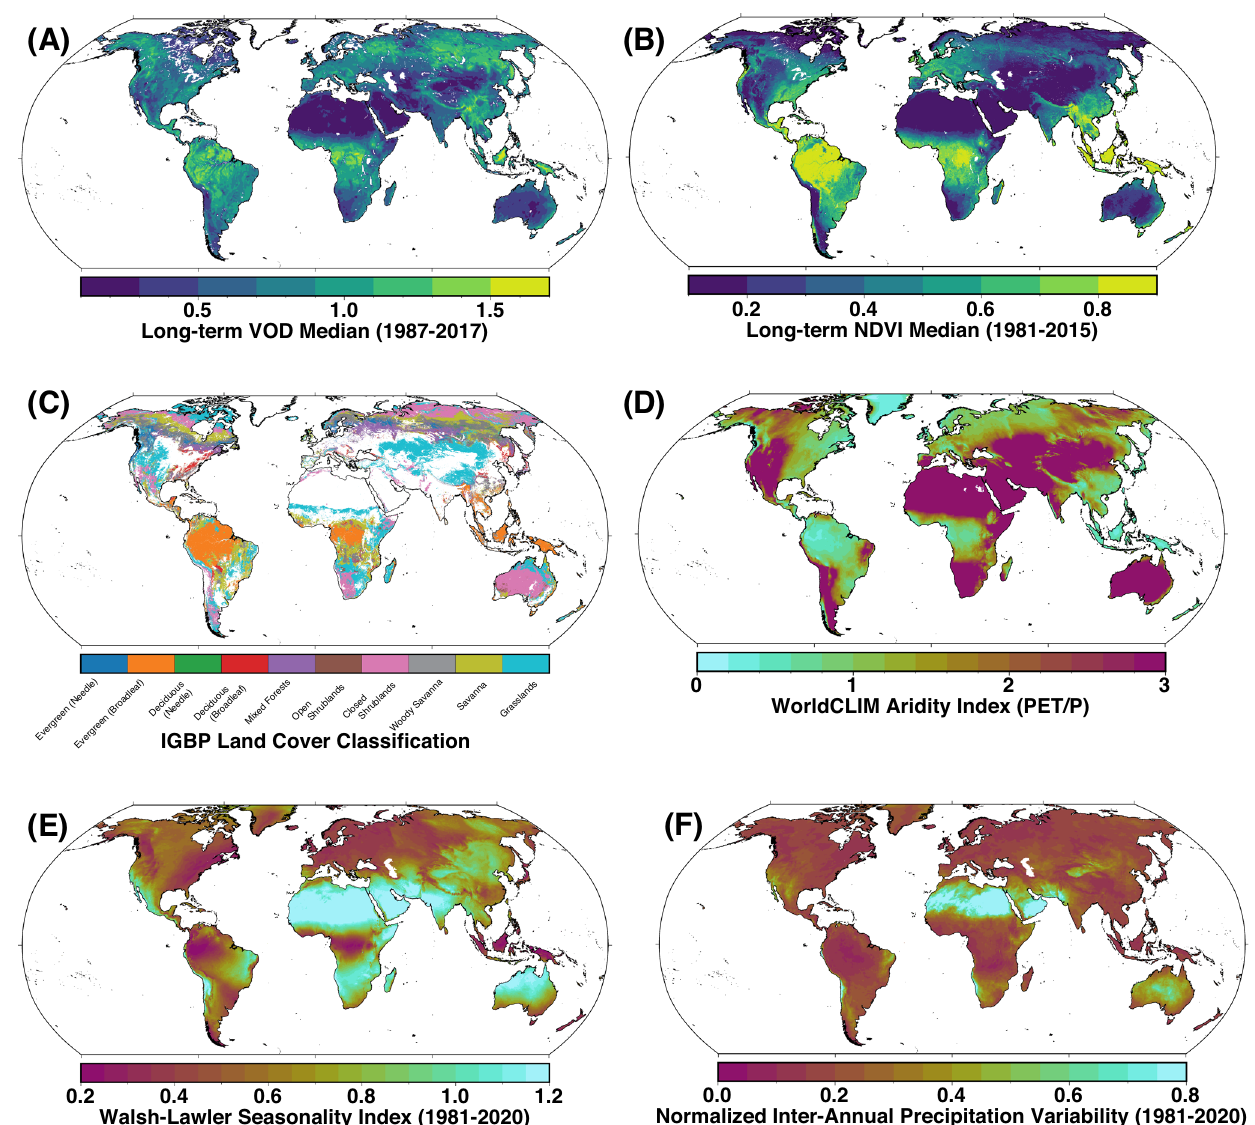
Fig. 1 | Spatial distribution of data used in this study. Long-term median A vegetation optical depth (VOD, 1987 – 2017, 23 ) and B normalized difference vegetation index (GIMMS3g NDVI, 1981 – 2015, 24 ). C IGBP Land-cover classes 46 , masked for anthropogenic in fl uence (Methods). D Global aridity index, adapted